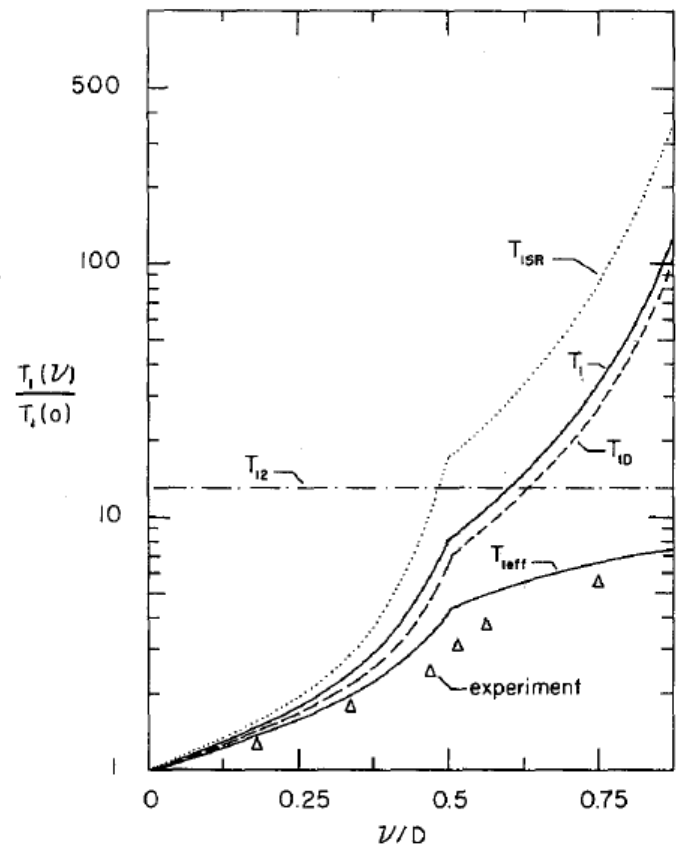
Figure 16. Variation of the nuclear spin-lattice relaxation with frequency for a glass ordering in solid ortho-para hydrogen mixtures. Reproduced with permission from [47]. Copyright Springer Nature,